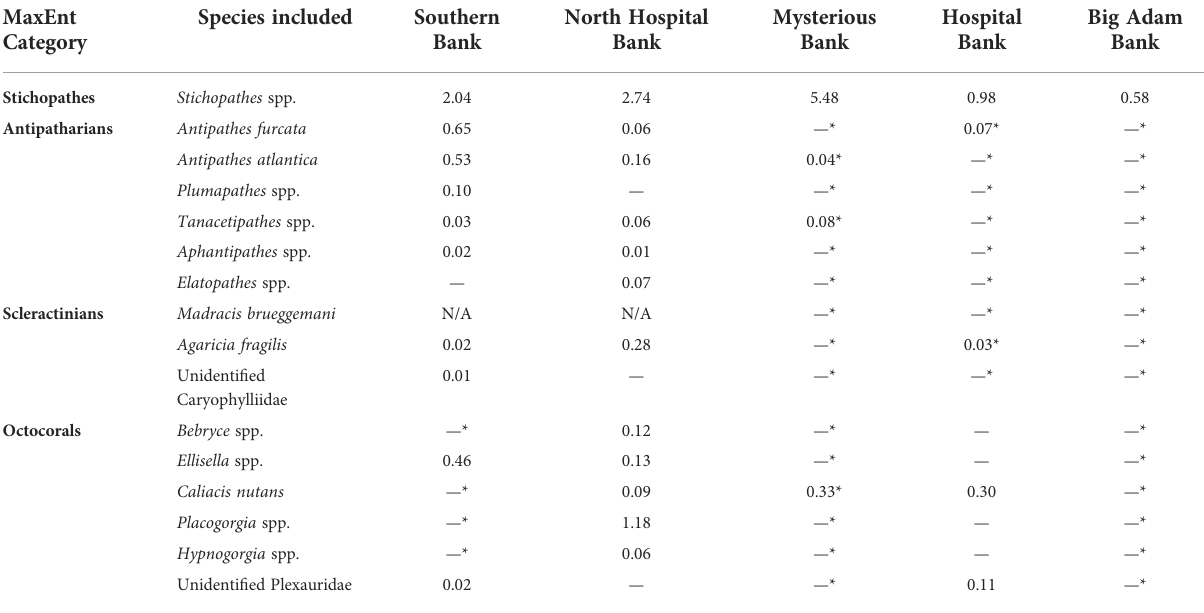
Average density (individuals/m 2 )